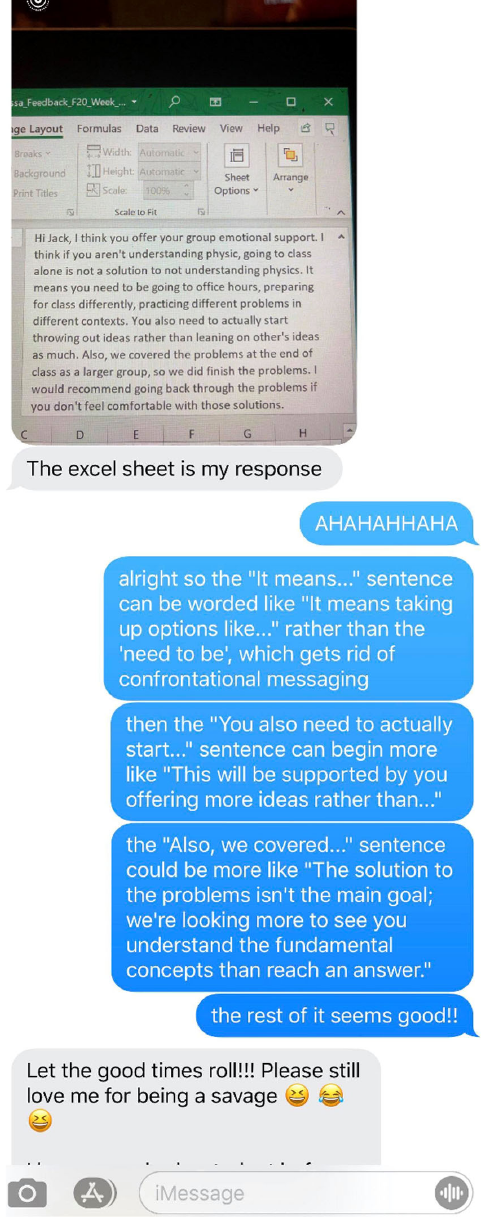
FIG. 2. Text exchange between Erica and a TA, exemplifying strong relationships within the student teaching staff of P-Cubed. The blue bubbles on the right show Erica ’ s suggestions for the TA ’ s feedback, while the gray bubble on the left shows the TA ’ s response to Erica ’ s